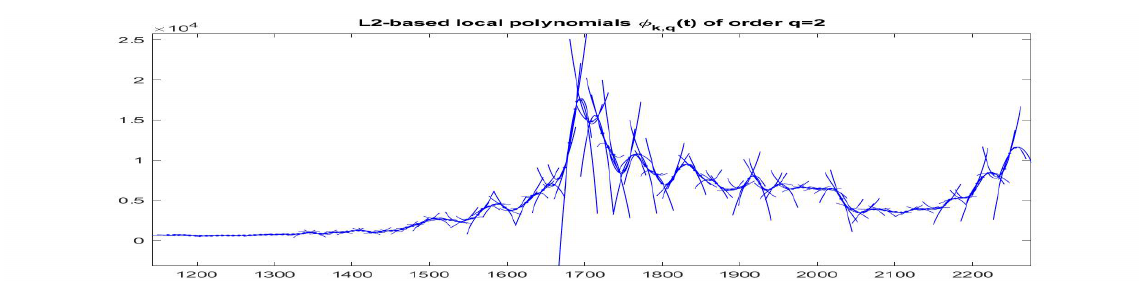
Figure 22. L 2 -norm F-transform components of order 1 for Bitcoin series. The fuzzy r -partition is P b with r = 3.